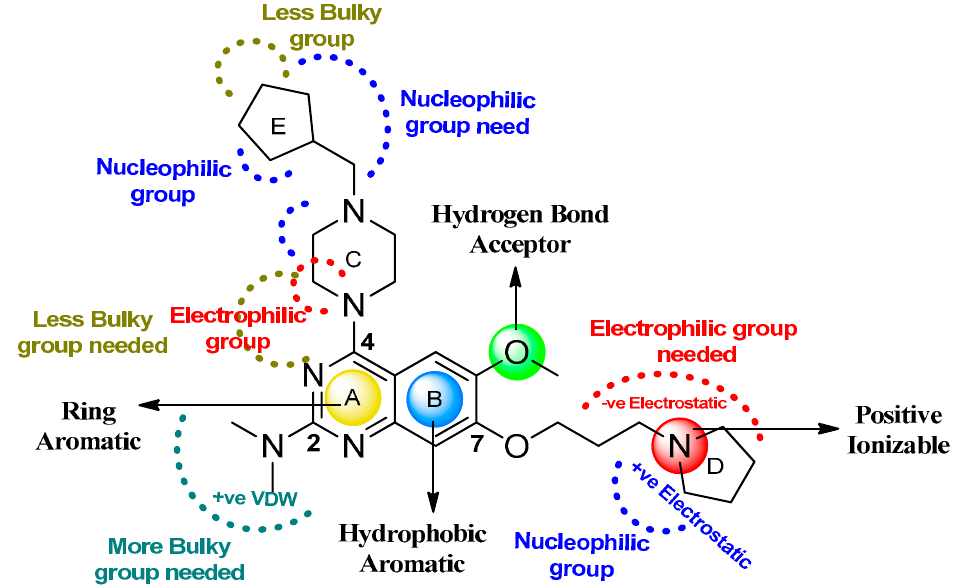
Figure 14. Distribution of structural attributes on quinazoline scaffold of compound 14 obtained from ligand ‐ based drug design.